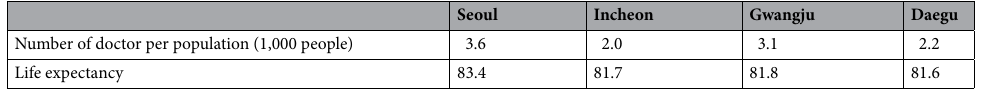
Table 5. Average characteristics for each region in 2017–2018. Number of doctor per population 50 ; life expectancy 46